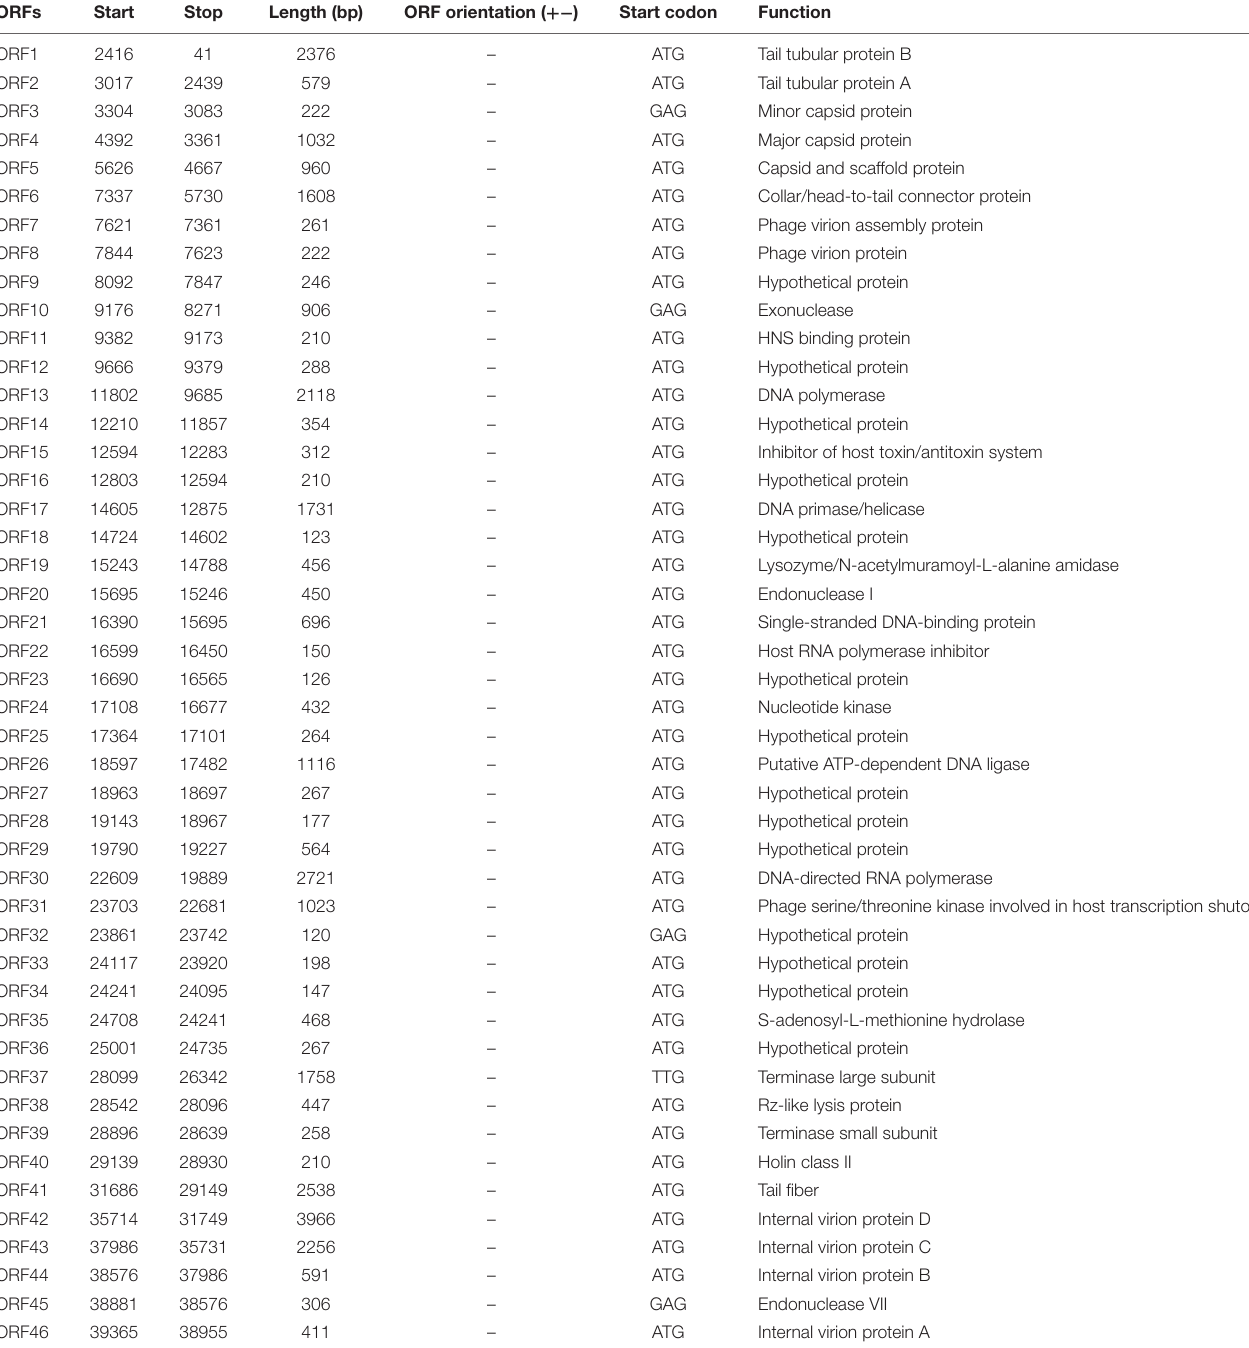
TABLE 1 | Open reading frames (ORFs) of phage